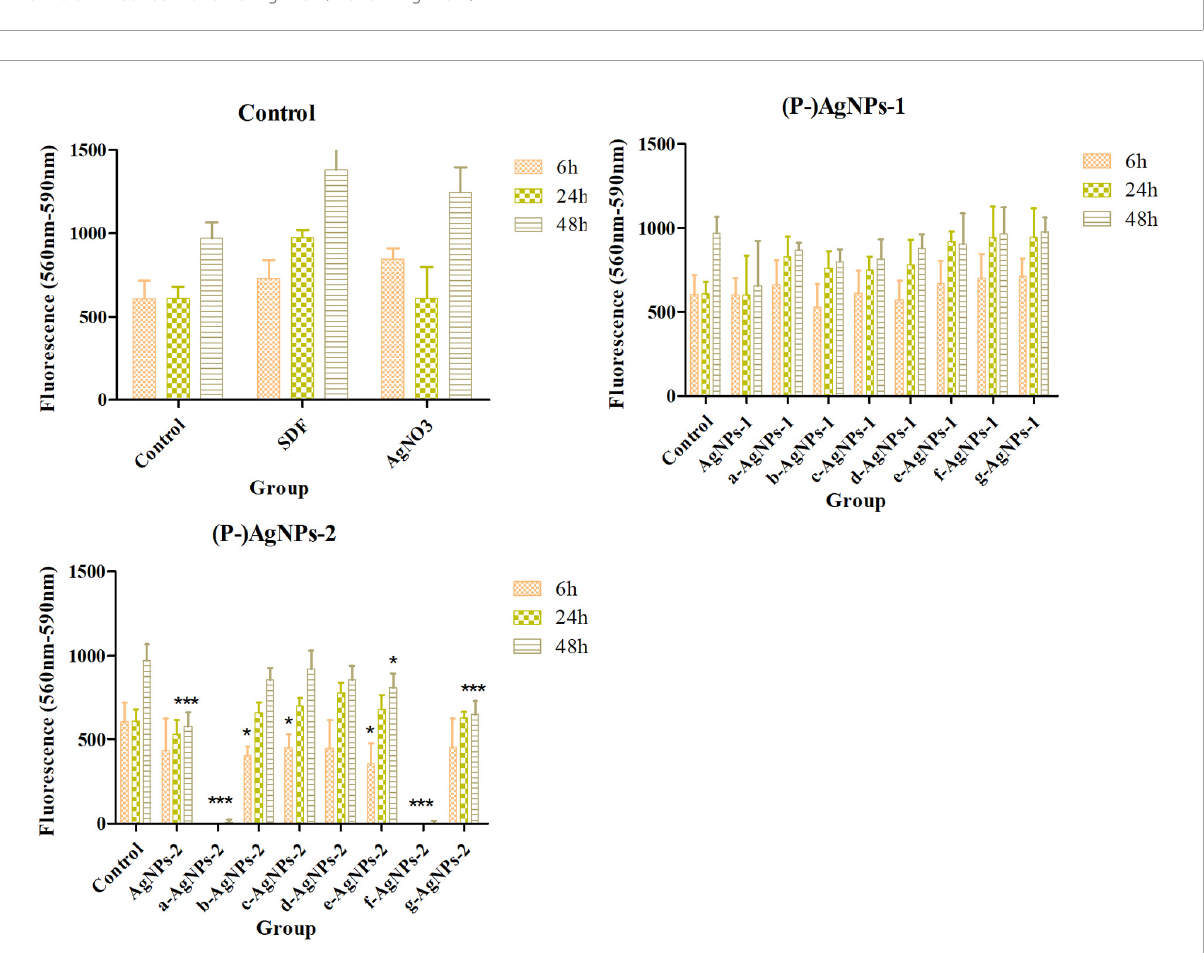
FIGURE7 Cytotoxicity of AgNPs-1/2 and P-AgNPs-1/2 on human gingival fibroblasts at 6, 24, and 48 h. “*” P < 0.05, “**” 0.05 < P < 0.005, “***” P < 0.001.